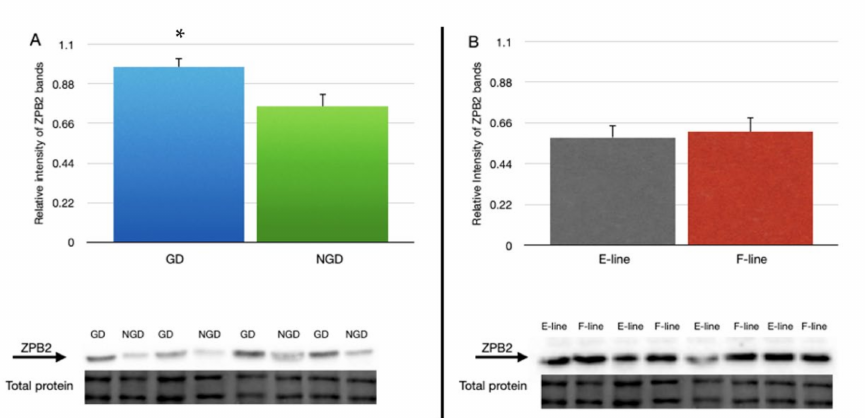
Figure 2. Relative abundance of ZPB2 protein in the perivitelline layer of laid eggs between ( A ) the non-germinal disc (NGD) region and germinal disc (GD) region with a representative blot for ZPB2 comparing GD and NGD regions and the section of total protein used for normalization. ( B ) Relative abundance of ZPB2 in the perivitelline layer of laid eggs between two genetic lines of turkey hens selected for either egg production (E-line) or rapid body growth (F-line) along with a representative blot for ZPB2 and total protein. For ( A ), n = 12 replicate samples per perivitelline location (6 E-line eggs plus 6 F-line eggs), and for ( B ), n = 12 replicate samples (6 GD plus 6 NGD) per genetic line. Values represent the mean ± SEM. * indicates significant difference in means, p <